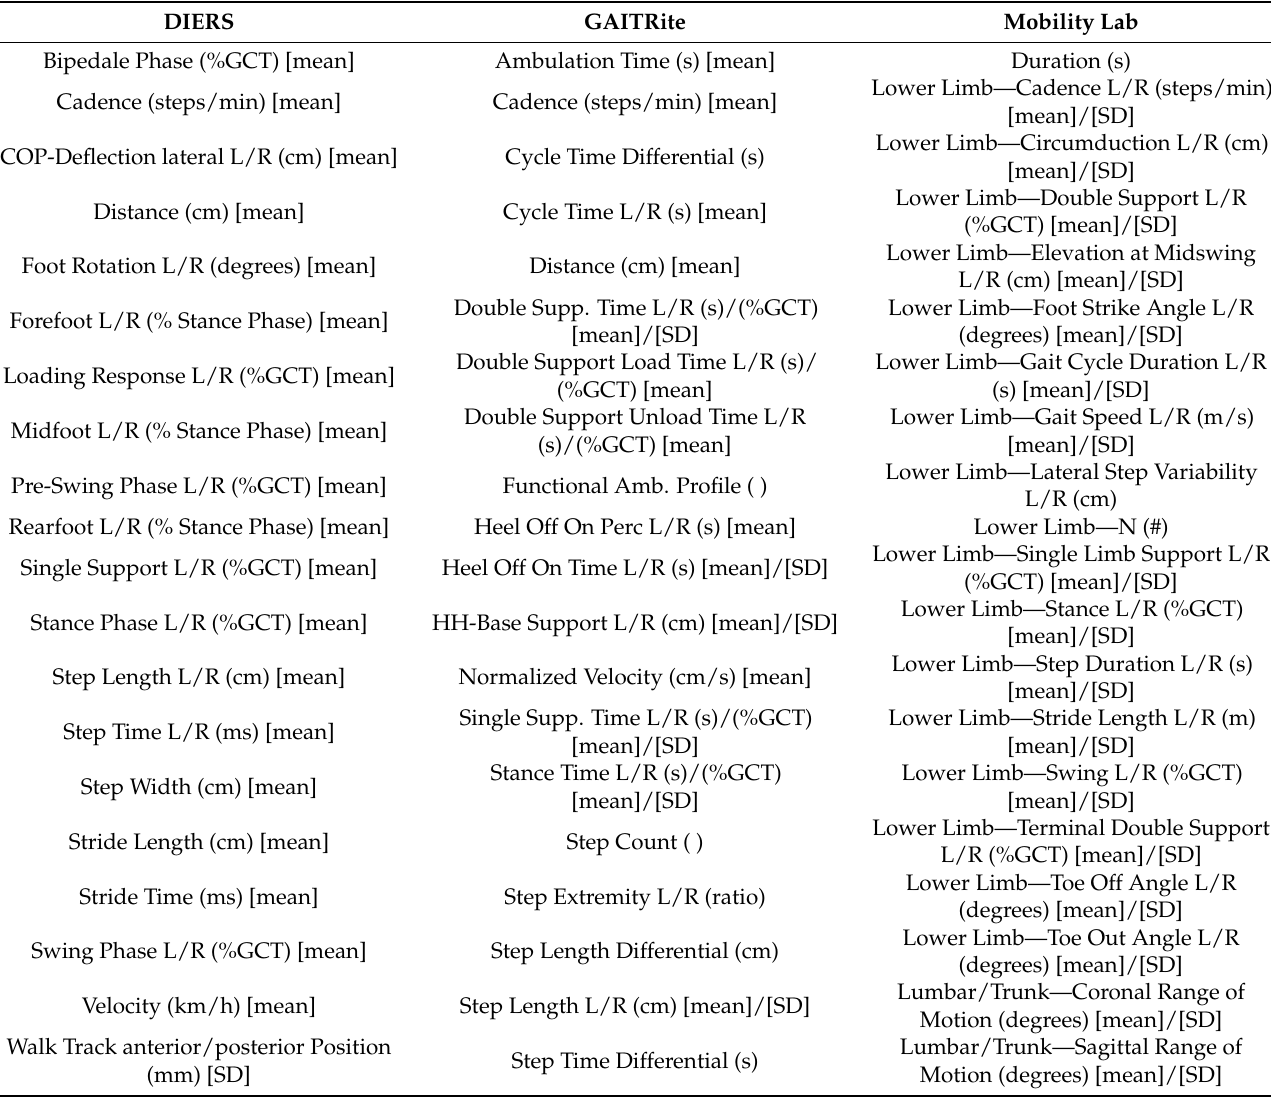
Table 1. Recorded gait parameters of three diagnostic gait analysis systems; the unit of each gait parameters is shown in parentheses. The parameters have been recorded and merged for the left and right sides (L/R); The parameters are presented as mean [mean] or standard deviation [SD]; ( )—dimensionless values; COP = center of pressure; GCT = gait cycle time; HH = heel to